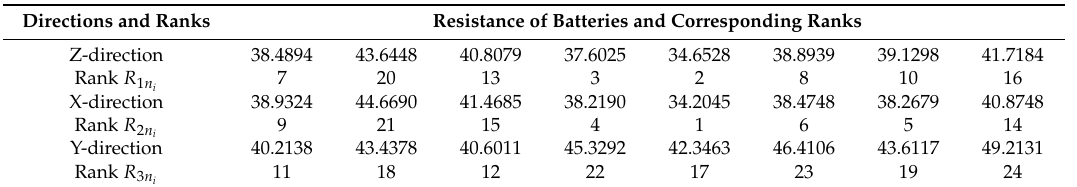
Table 9. The resistance samples of batteries and corresponding ranks in order under the vibration conditions applied in Z/X/Y-directions. Directions and